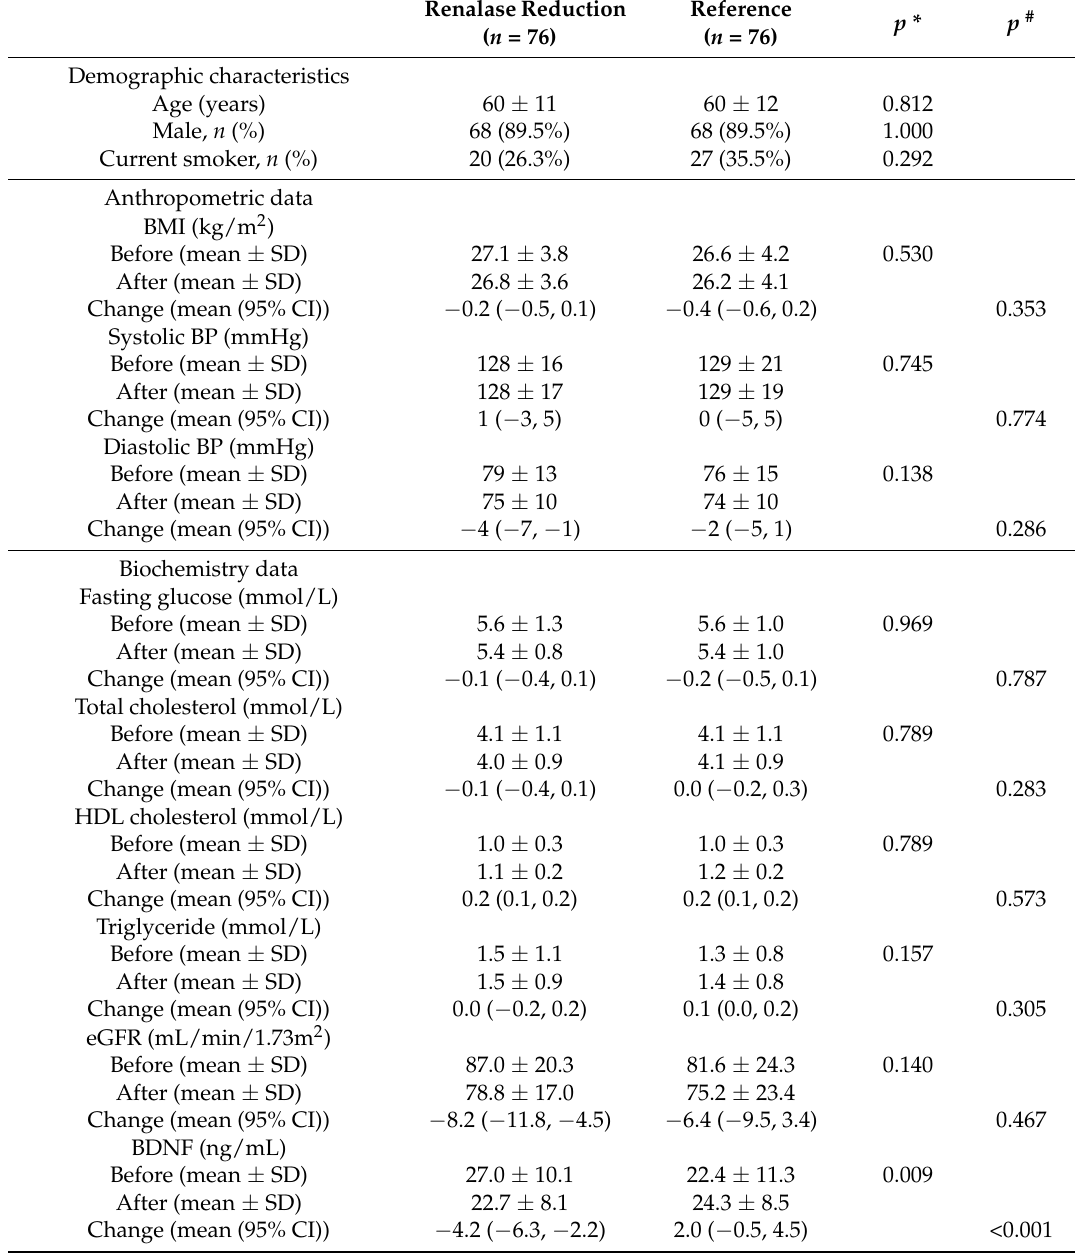
Table 3. Clinical data before and after percutaneous coronary intervention (PCI) among patients categorized based on the median percentage change in renalase levels